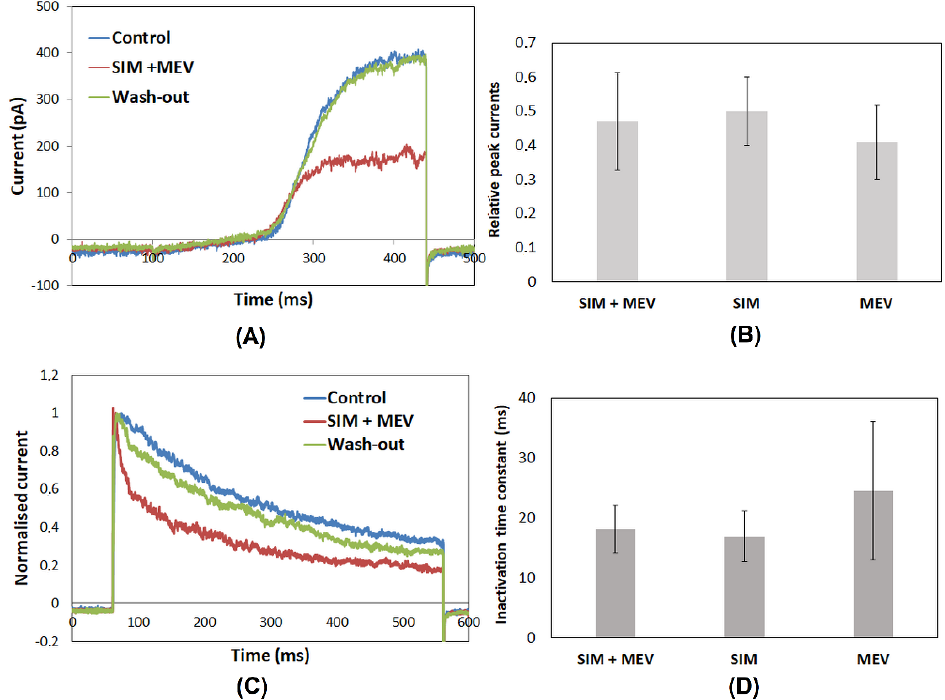
Figure 1. Examples of whole-cell Kv1.3 currents recorded applying the voltage ramp (see Materials and Methods) under control conditions, upon co-application of simvastatin (SIM) at the concentration of 6.0 μ M with simvastatin (SIM) at the concentration of 6.0 μ M, and after wash-out of the drugs ( A ); relative peak currents (defined in Materials and Methods) upon co-application of the statins and application of each statin alone ( B ); normalized whole-cell Kv1.3 currents recorded applying the voltage step (see Materials and Methods) under control conditions, upon co-application of the statins, and after wash-out of the drugs ( C ); inactivation time constants upon co-application of the statins and application of each statin alone ( D ).